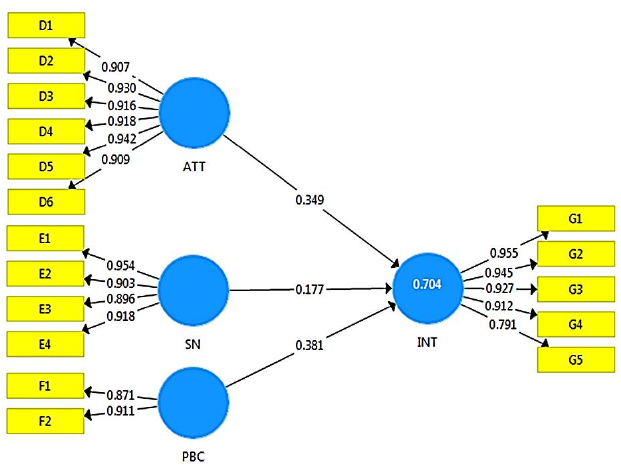
Figure 1. Measurement model.